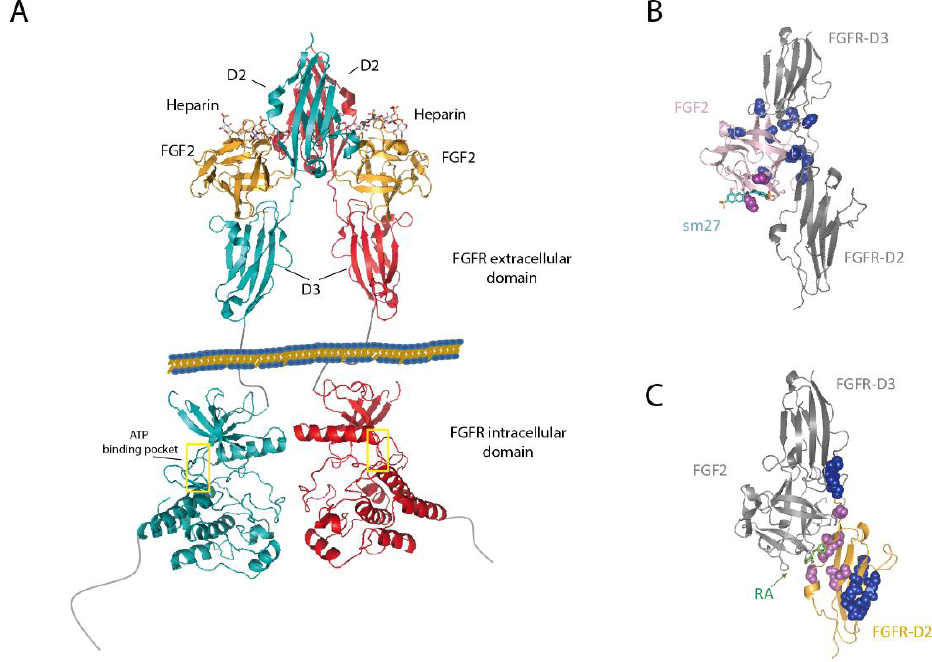
Figure 1. Structural features of the extracellular FGFR portion in complex with FGF2 and heparin, as well as the intracellular portion, including the ATP binding pocket (yellow rectangles), as derived from 1FQ9 [11] and 1FGI [8] PDB data, respectively ( A ). SM27 ( B ) and rosmarinic acid (RA) ( C ) binding sites (pink spheres) on FGF2 and FGFR-D2, respectively. Regions affected by long-range dynamic perturbations along the FGF2/FGFR interface region are highlighted with blue spheres.